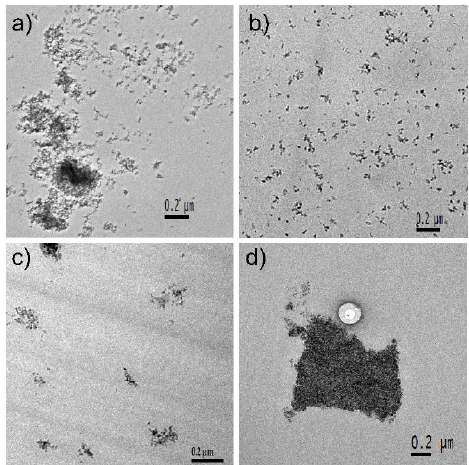
Figure 4. Representative TEM-images of ultramicrotome-cuts (100–300 nm thickness) of 5 wt% ZrO 2 nanoparticle in epoxy resins. ( a ) ZrO 2 unmodified, ( b ) 5% DEG-PPA@ZrO 2 , ( c ) 5% Diol-PPA@ZrO 2 , ( d ) 5% Ep-PPA@ZrO 2 . Images ( a , b ) were reproduced with permission of John Wiley & Sons Ltd. from a previous publication for reasons of comparison [24].